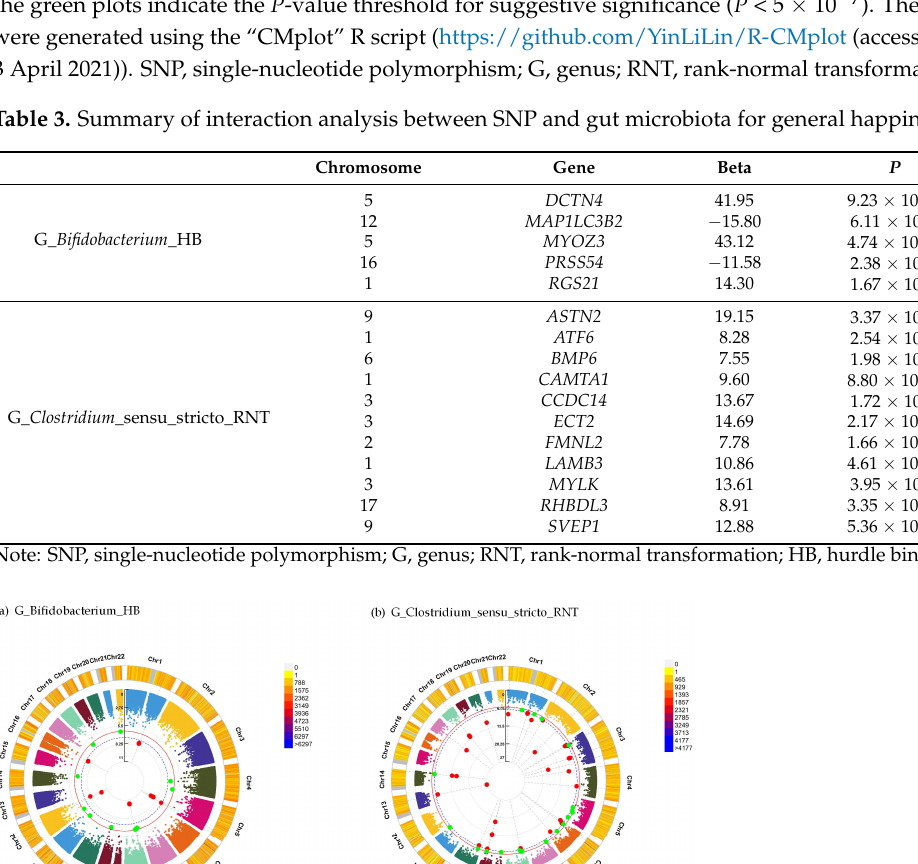
Figure 2. Interaction analysis between SNP and gut microbiota for general happiness. Chromosomal regions interacting with G_ Bifidobacterium _HB ( a ) and G_ Clostridium _sensu_stricto_RNT ( b ) for general happiness. From the center, the first circos depicts the –log 10 P of each variant owing to double exposure, i.e., the effect of both single nucleotide polymorphism allele and gut microbiota. The second circos shows chromosome density. Red plots indicate the P -value threshold for genome- wide significance ( P < 5 × 10 − 8 ), while the green plots indicate the P -value threshold for suggestive significance ( P < 5 × 10 − 7 ). The plots were generated using the “CMplot” R script (https://github.com/YinLiLin/R-CMplot (accessed on 3 April 2021)). SNP, single-nucleotide poly- morphism; G, genus; HB, hurdle binary; RNT, rank-normal transformation.